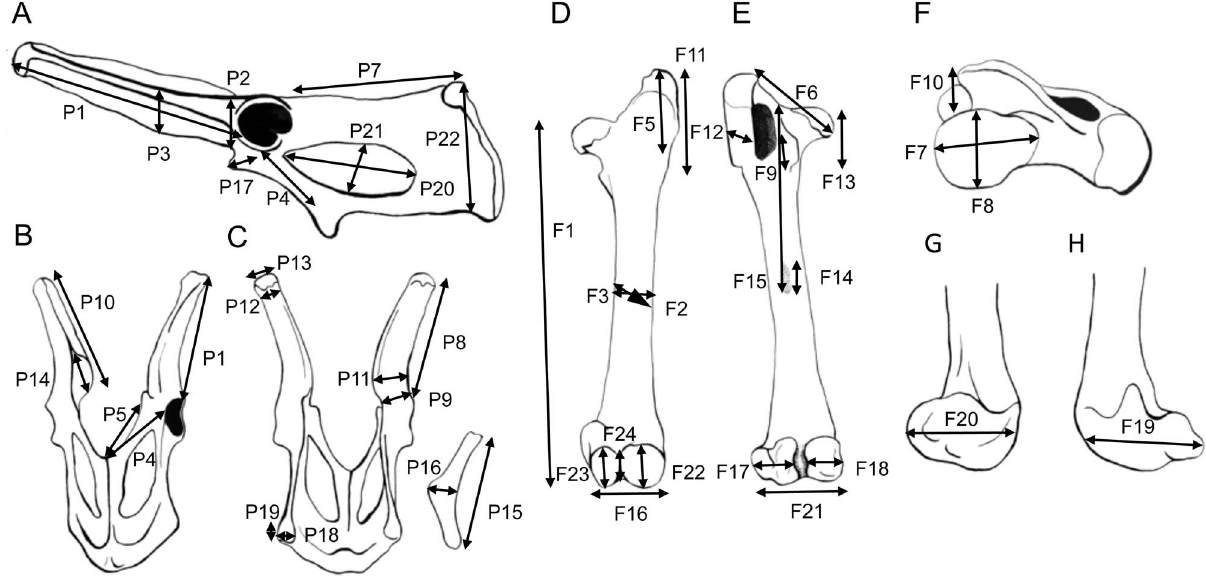
Figure 8. Measurements used in analyses-1. Drawings, all of left side elements, primarily from photographs of Macropus fuliginosus , AMNH 2390. (A) Pelvis, lateral view. (B) Pelvis, ventral view. (C) Pelvis, dorsal view. (D) Femur, anterior view. (E) Femur, posterior view. (F) Femur, proximal articular view (anterior of shaft downwards). (G) Distal femur, medial view. (H) Distal femur, lateral view. A detailed description of the measurements is provided in Table S2.